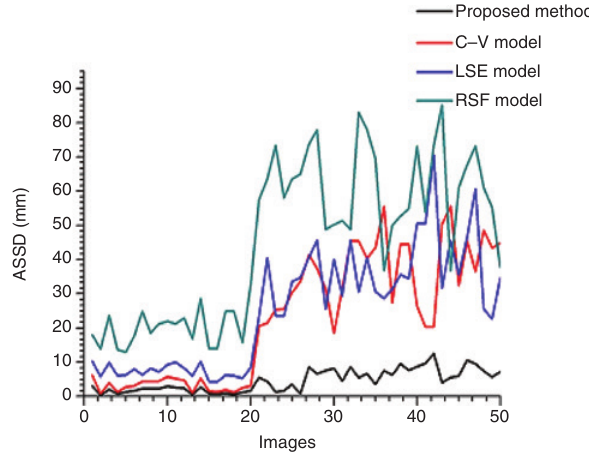
Figure 11: Comparison of Results Using ASSD for CT Scan